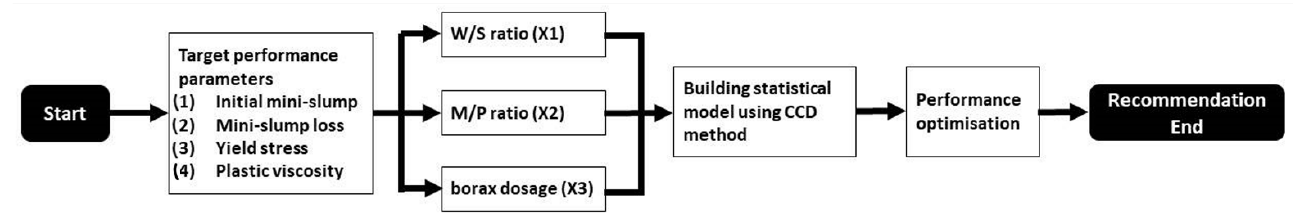
Figure 1. Illustration of overall experimental design for this